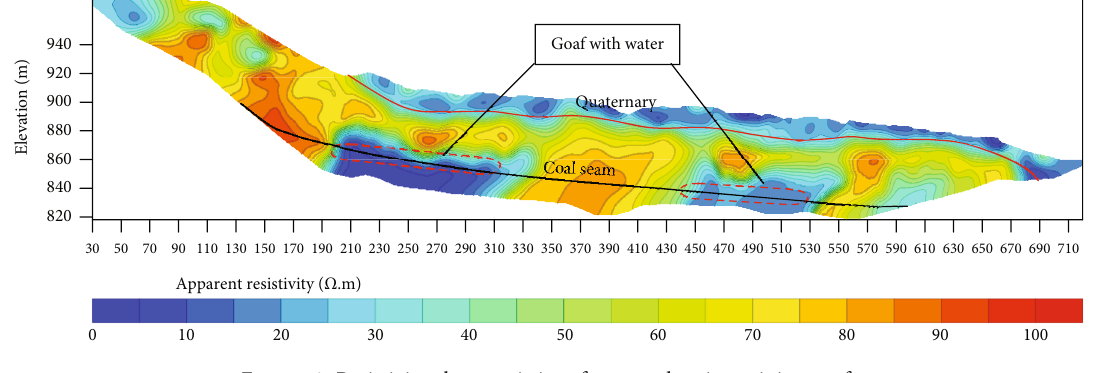
Figure 9: Resistivity characteristics of a water-bearing mining